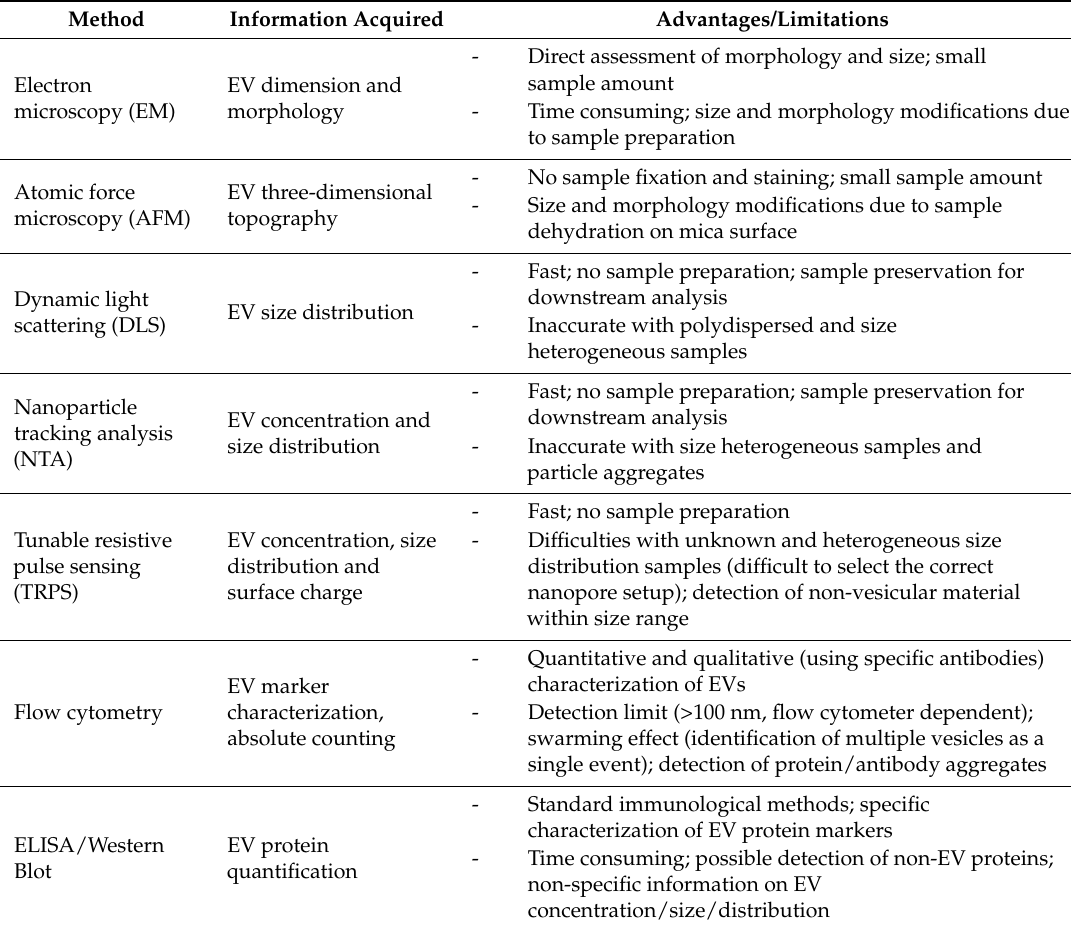
Table 2. Methods for EV